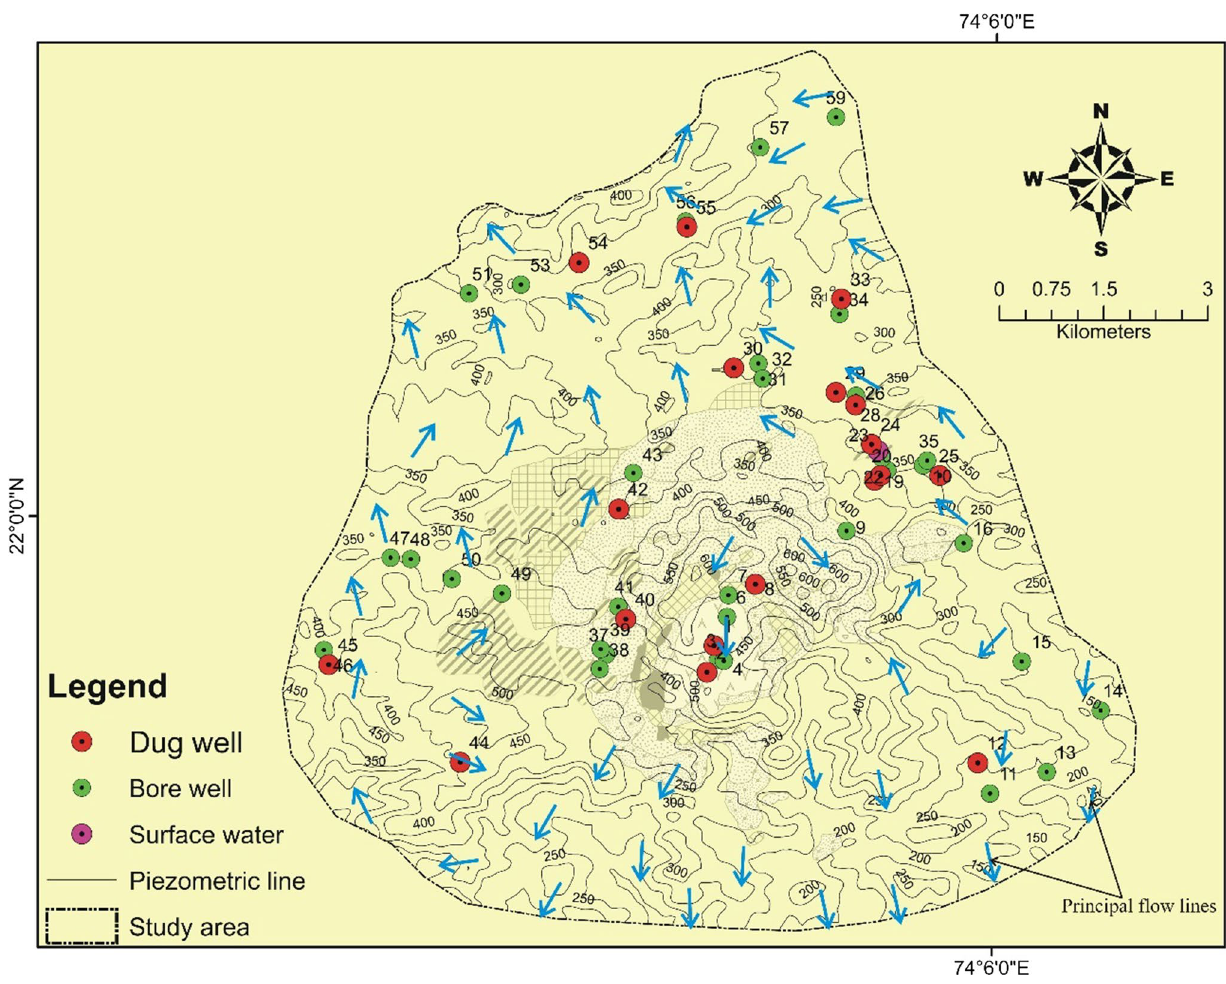
Fig. 3 Piezometric map showing sampling